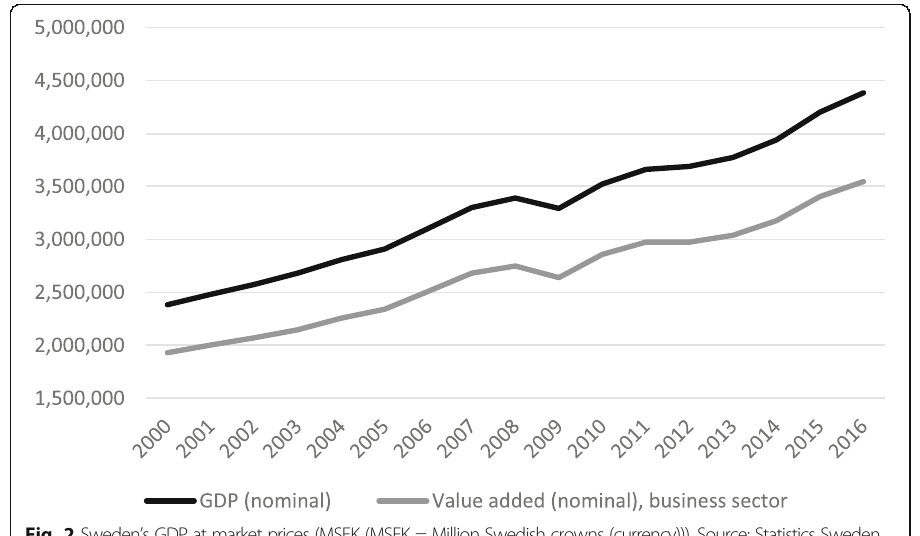
Fig. 2 Sweden ’ s GDP at market prices (MSEK (MSEK = Million Swedish crowns (currency))). Source: Statistics